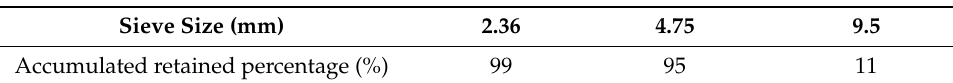
Table 4. Sieve analysis of aggregate.